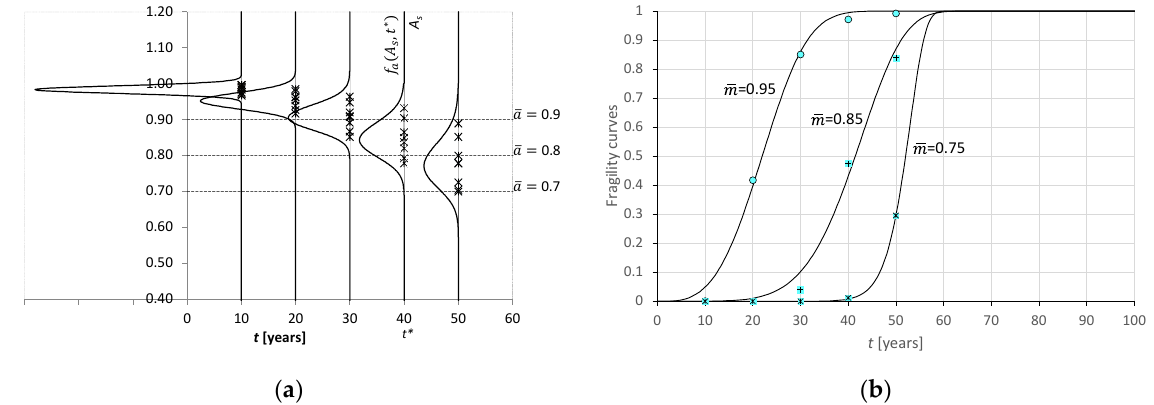
12 of 17 Figure 5. “Statistical truth” for e m z : ( a ) Exceedance probability of reaching the threshold (cid:1865)(cid:3365) defined by (cid:1832) (cid:3040) ((cid:1865) (cid:3053) , (cid:1872) ∗ ) ; ( b ) experi- mental (symbols) and theoretical (lines) fragility curves, (cid:1832) (cid:3021)(cid:3364)(cid:3040) ((cid:1872)) , for the thresholds (cid:1865)(cid:3365) . Consequently, the constructed curves describe the probability o the studied system not being able to guarantee, at any instant t , an ultimate bending moment greater than or equal to (cid:1865)(cid:3365) . 4.3. Fragility Curves as Indicators of Possible Monitoring Scenarios Once constructed the statistical truth, it may now be interesting to verify the error that could be made if the fragility curves were constructed on the basis of monitoring performed at different intervals of time and with a limited sampling of investigations. The situation described is very frequent in professional practice. In this context, 1000 experimental measurements (samples) are rarely available; therefore, the intent is to verify the validity of the proposed procedure if a small number of samples is available. To simulate these actions, 10 random samples were extracted from the probability distributions of m z (Figure 4a) referring to certain instants of life of the structure (e.g., 10, 15, 20, 25, 30, and 40 years) as many detections of the degradation operated in a hypothet- ical monitoring action. To better grasp the epistemic and random uncertainties that may be inherent in the experimental data, the extracted samples were further altered with a random procedure (addition of a percentage of random error subtraction). The choice of 10 samples was based on the authors’ previous experience in this field. In the following, we will call this analysis experimental in the sense that it simulates experimental data. The influence of the number of samples on the accuracy of the results is evident in Figure 6a. The further one moves away from the initial state ( t 0 ), the greater the dispersion of the statistical data becomes, highlighting the need to plan a more extensive sampling as the service life of the bridge increases.